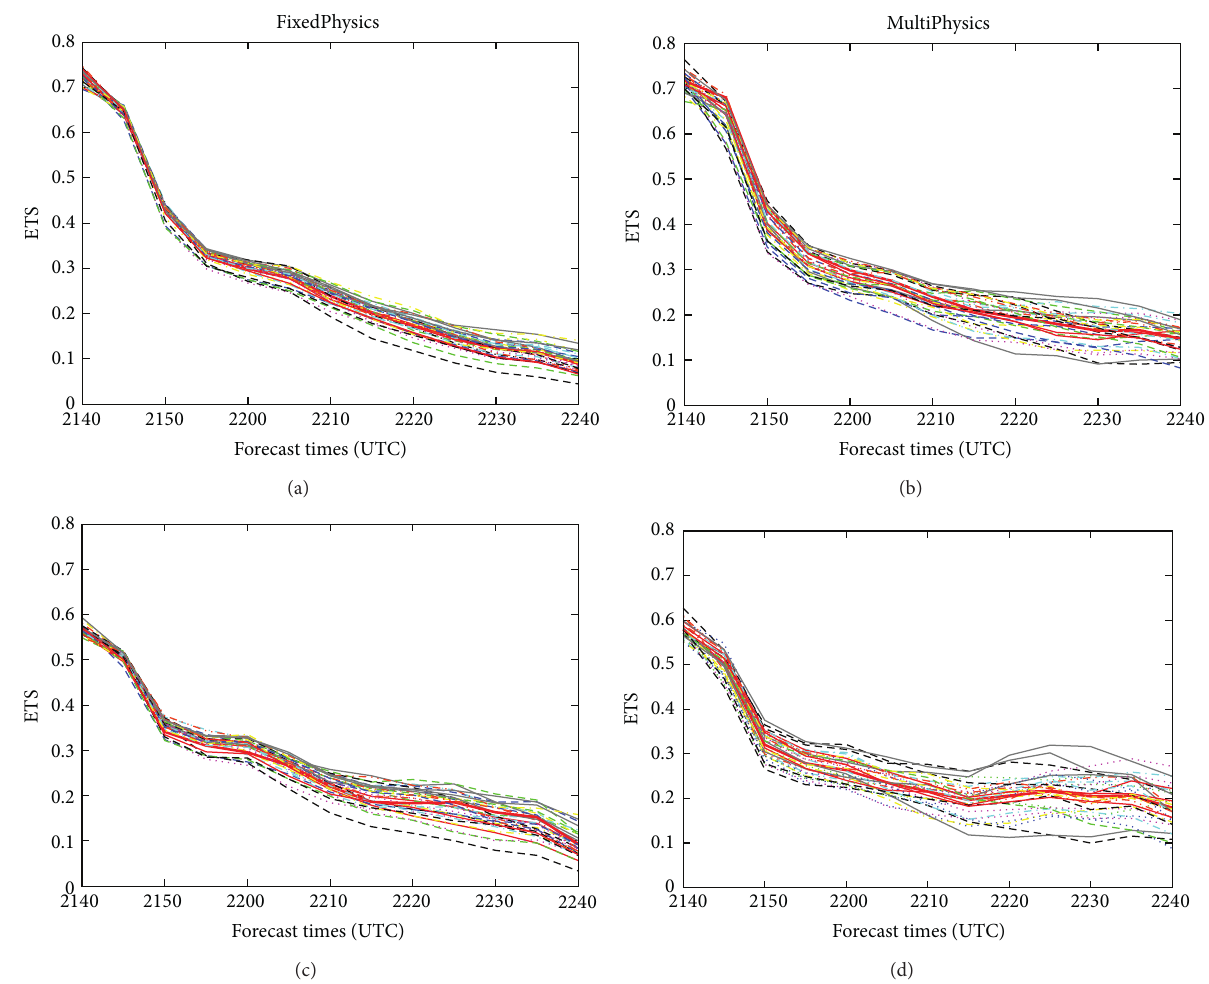
Figure 8: Values of equitable threat score (ETS) for reflectivity thresholds of ((a), (b)) 35 dBZ and ((c), (d)) 45dBZ as a function of forecast times (UTC) from the convective-scale FixedPhysics and MultiPhysics 36-member ensembles (thin lines) and ensemble mean (thick lines). The independent 3DVAR analyses of reflectivity are used as